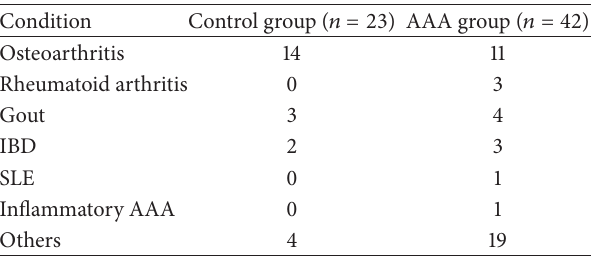
Table 2: Inflammatory diseases in the control and AAA groups.